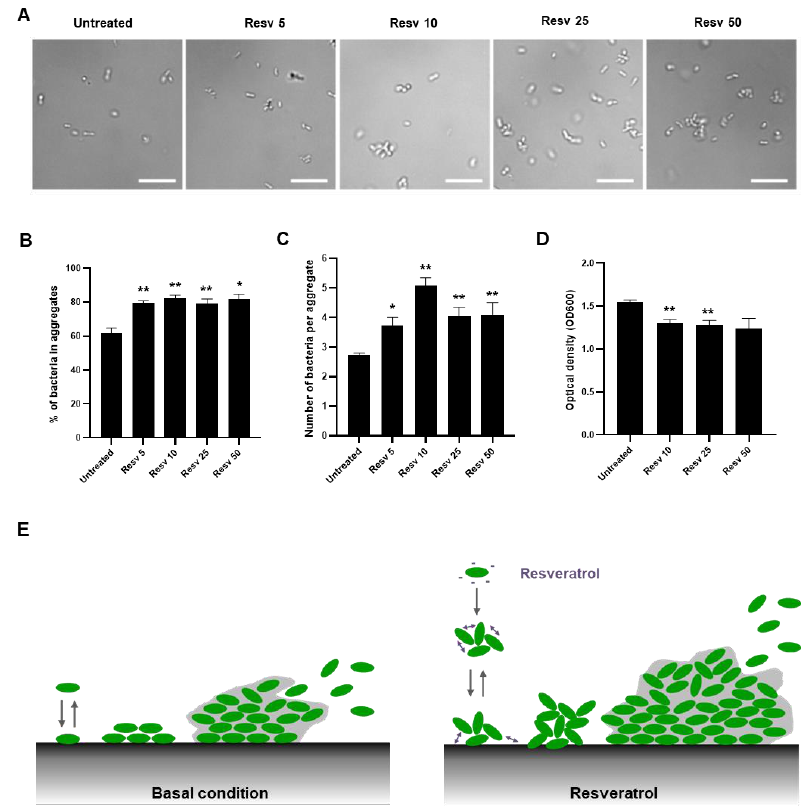
Figure 5. Resveratrol promoted L. paracasei ATCC334 aggregation. ( A ) Representative micrographs